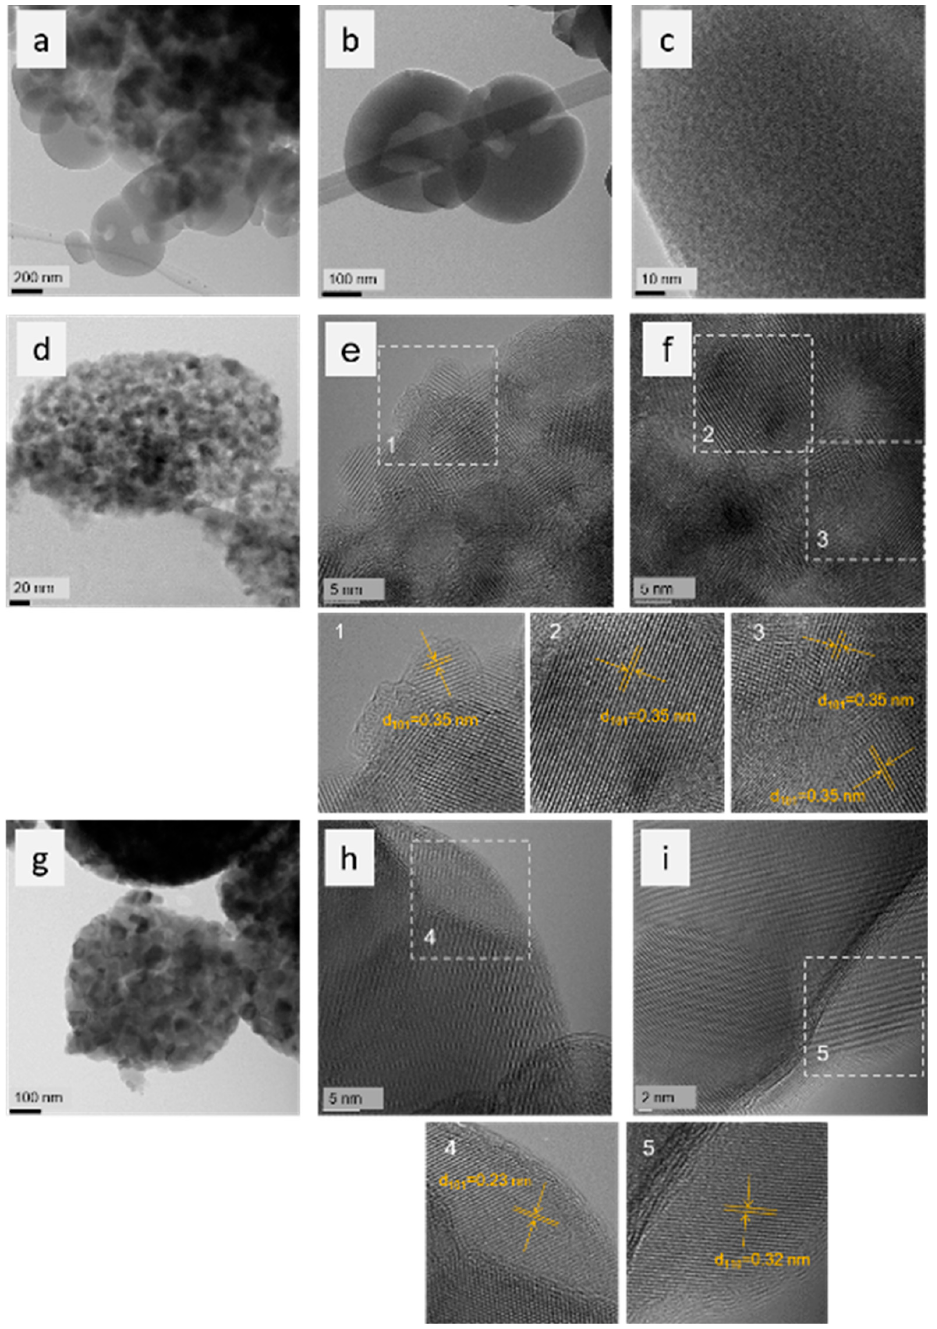
Figure 5. TEM images of MIL125-(Ti): ( a – c ), MT-500 ( d – f ) and MT-600 ( g – i ) at different magnifications. Distinctive interplanar spacings are evidenced in yellow (enlargements of selected areas are also reported for a better visualization of the interplanar distances).